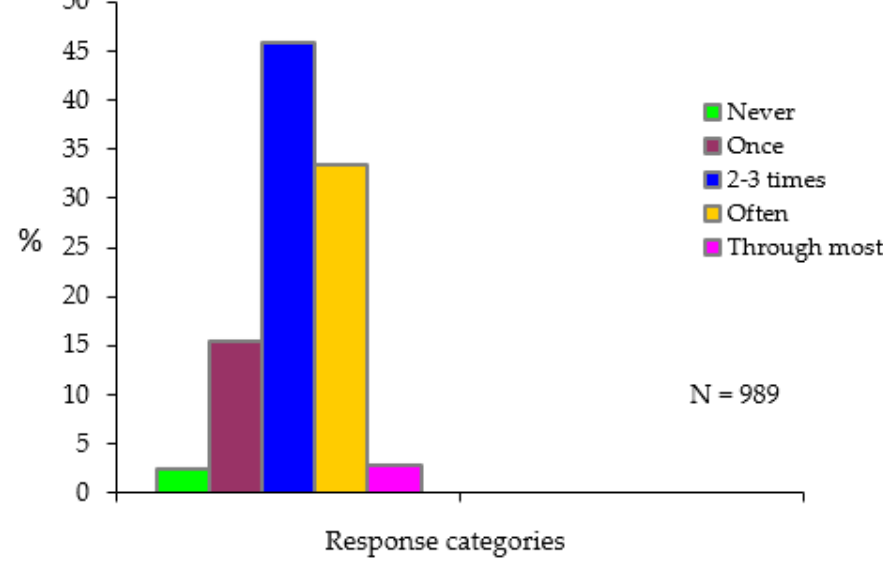
Figure 4. Thought of experiences’ frequencies for all inductees.